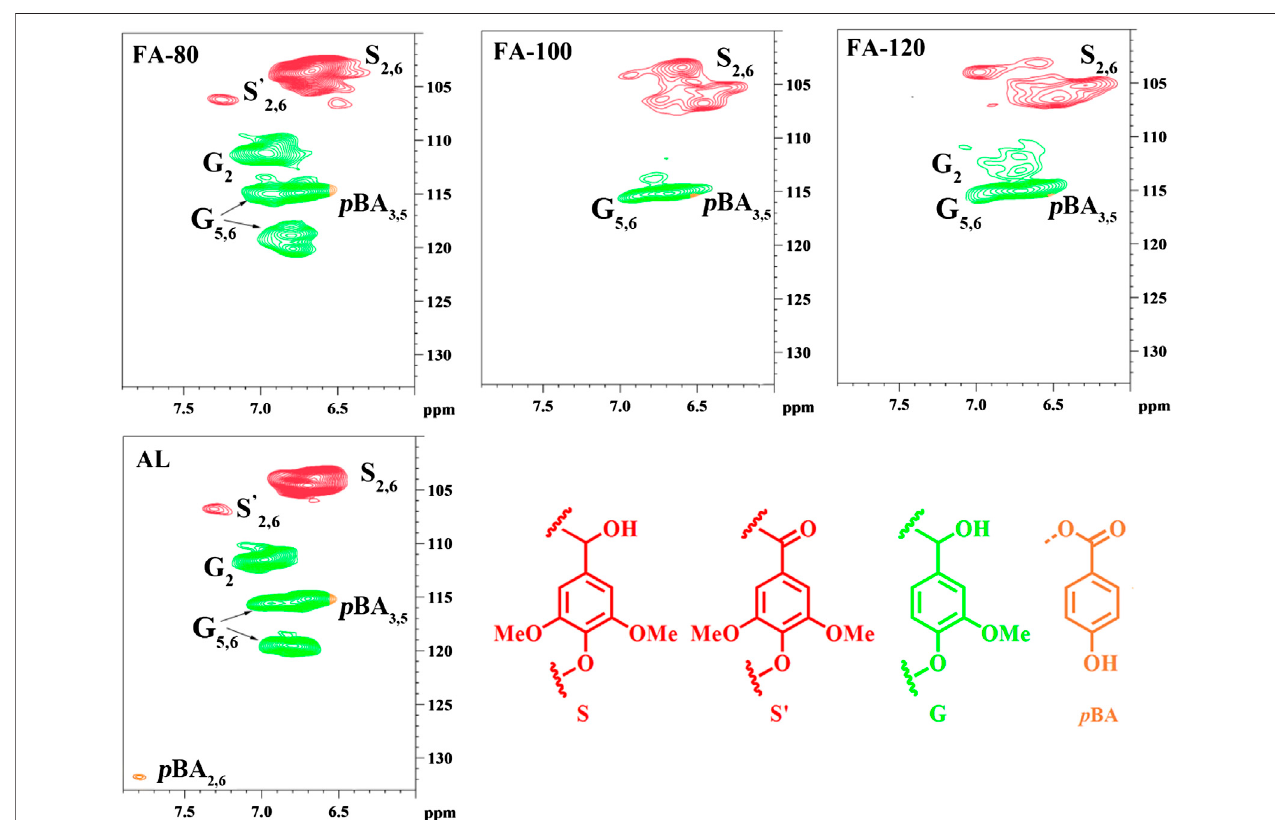
FIGURE 2 | Aromatic regions in the 2D-HSQC spectra of lignin samples.